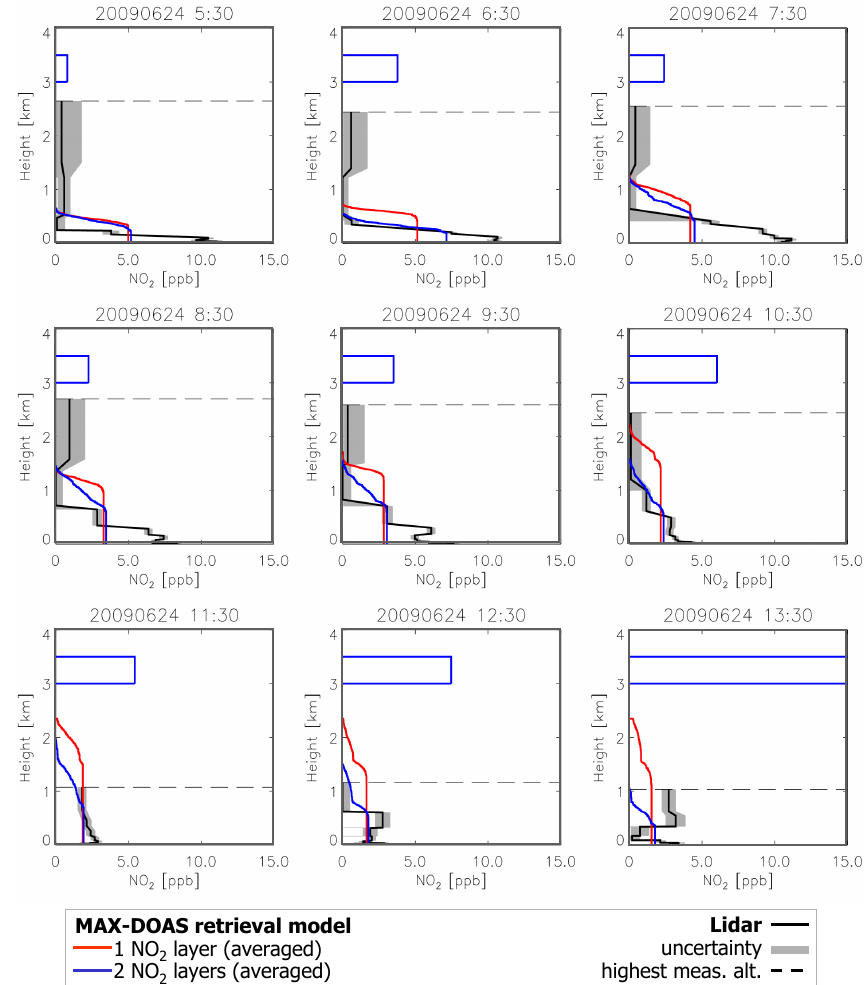
Fig. 12. Lidar NO 2 profiles and MAX-DOAS retrievals measured at the CINDI campaign on the 24 June 2009. The lidar profile is shown in black, with uncertainty estimate in gray and the highest measurement altitude shown with the dashed horizontal line. The average profiles retrieved with the MAX-DOAS one and two NO 2 layer algorithms are shown in red and blue respectively, they are obtained by averaging all block shaped profiles of the ensemble of 200 runs. During the first part of this day the agreement between the two measurements techniques in terms of tropospheric NO 2 columns was high, whereas the average NO 2 volume mixing ratio derived from MAX-DOAS was significantly below the NO 2 volume mixing ratio measured at the surface (Sect. 5.1). Note that NO 2 retrieved in the second layer of the two layer retrieval model should be interpreted as: NO 2 above approximately 1km, with unknown altitude (see Sect.